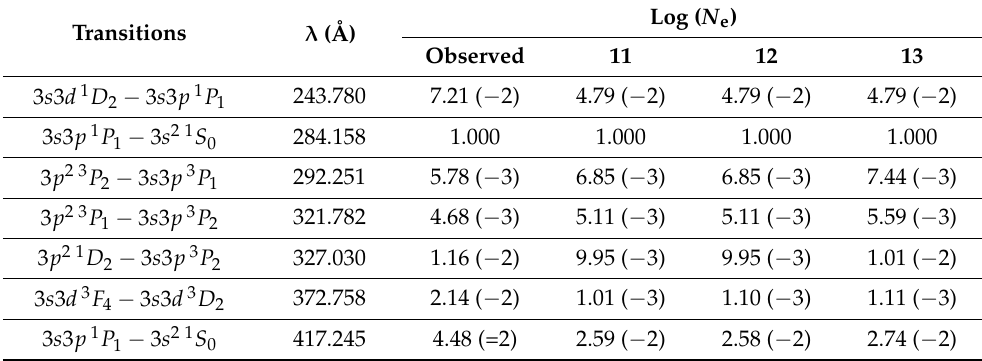
The lines at 292.251 and 321.782 Å indicate a density of N e = 10 11 cm − 3 . It is found that lines at 284.16 and 417.26 Å are optically thick (Kastner and Bhatia [46]). 9. Fe X There are three famous lines: the ‘green line’ at 5303 Å in Fe XIV, the ‘yellow line’ at 5694 Å in Ca XV, and the ‘red line’ at 6374 Å in Fe X in the Sun. The latter is a visible for- bidden line in the ground configuration 3 s 2 3 p 5 due to the transition 2 P 1/2 − 2 P 3/2 . Strong EUV lines in Fe X have been observed in the solar spectrum of the full Sun obtained by Milinovsky and Herous [47] during a sounding rocket flight. Thomas and Neupert [23] identified lines at 257.26 and 345.72 Å as Fe X lines in the SERTS-89 flight. Other observa- tions are of lines at 174.526, 175.265, 177.240, 184.534, 190.046, 220.862, and 257.246 Å from the SERTS-95 (Brosius et al. [48], and with improved calibration of lines at 174.5338 and 177.2477 (Brosius [49])). Bhatia and Doschek [50] calculated atomic data using configura-